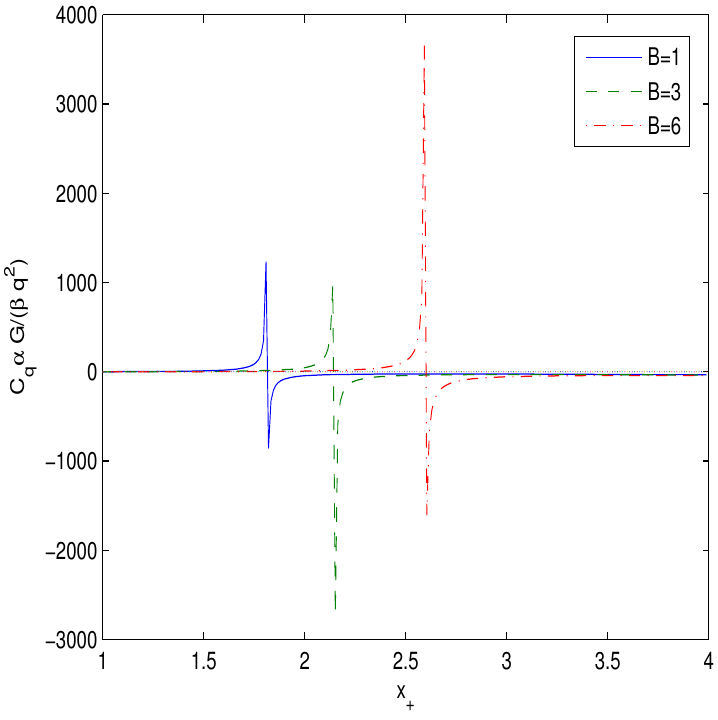
Figure 3. The plot of the function C q ( x + ) α G / ( β q 2 ) at C =